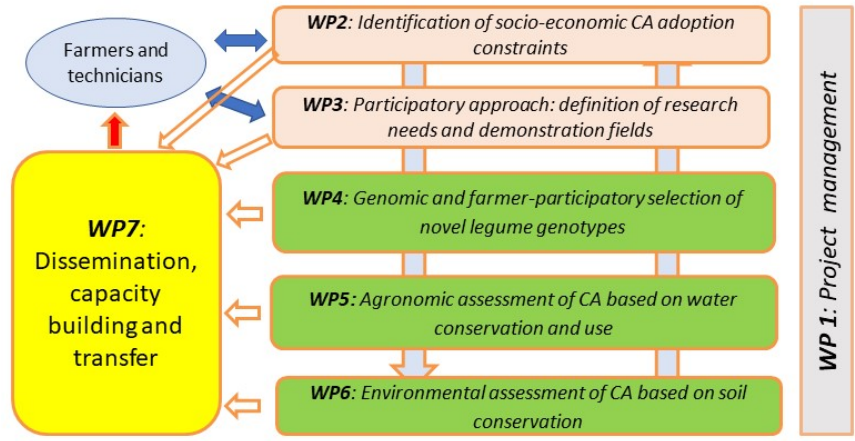
Figure 1. Interrelationships between Work-Packages (WP) in the CAMA project.